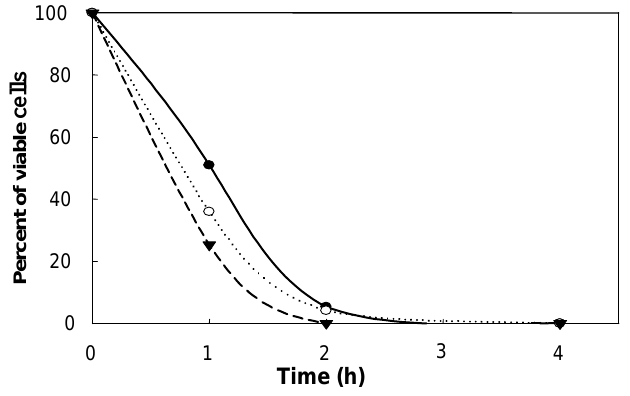
Figure 2 . Effect of 0.5% ( ● ), 1% ( ○ ), 1.5% ( ▼ ) limonene on viability of S. cerevisiae in batch cultivation with suspended